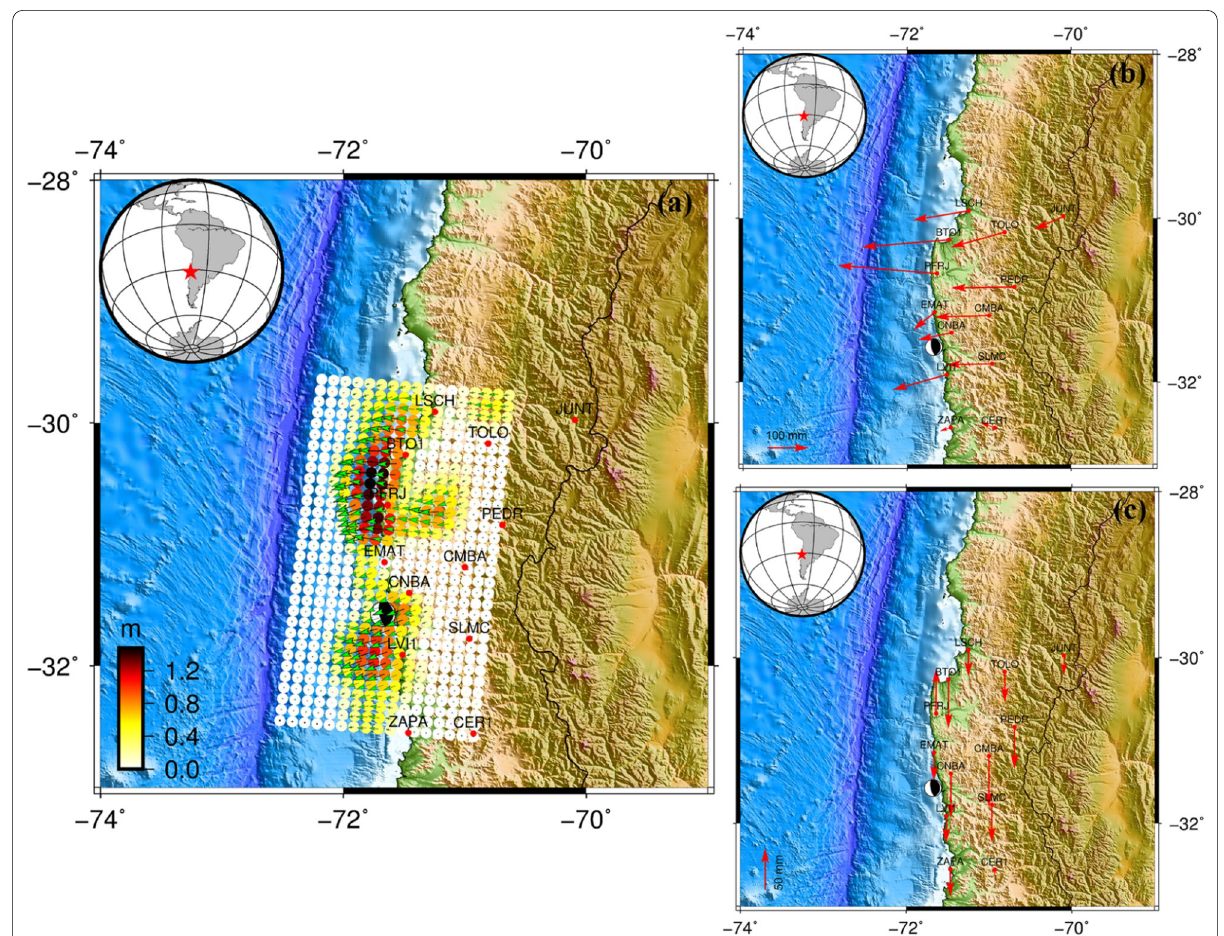
Fig. 8 Afterslip distribution ( a ) and postseismic deformations in the horizontal ( b ) and vertical ( c )